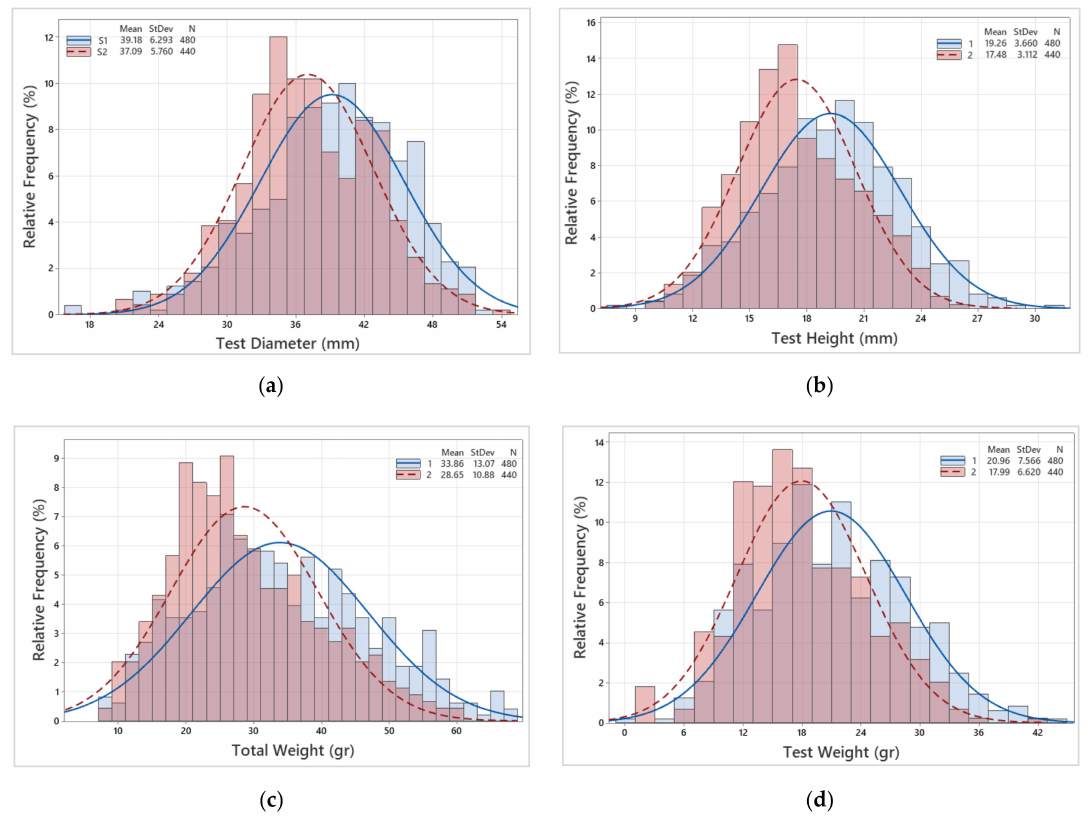
Figure 4. Arbacia lixula frequency distributions with overlaid fitted normal distribution for each sampling site of ( a ) test diameter, ( b ) test height, ( c ) total weight and ( d ) test